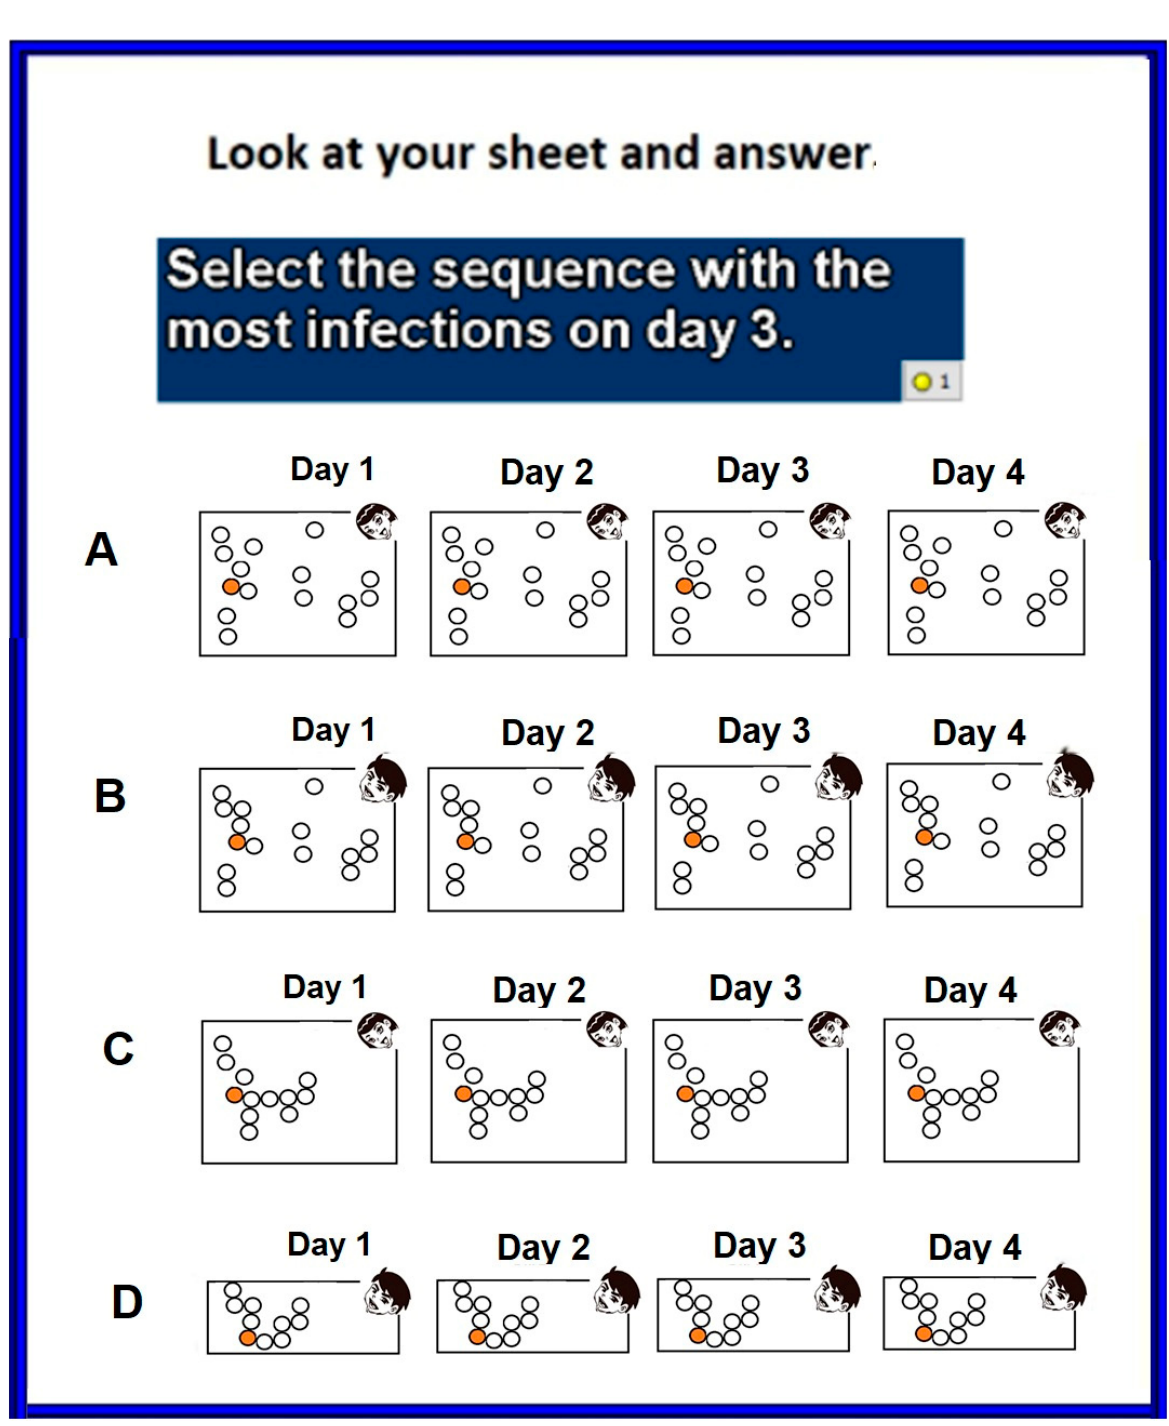
Figure 15. Example of a question that tested whether students understand a model of viral transmission across different days as a sequence of pool balls touching each other on a pool table.